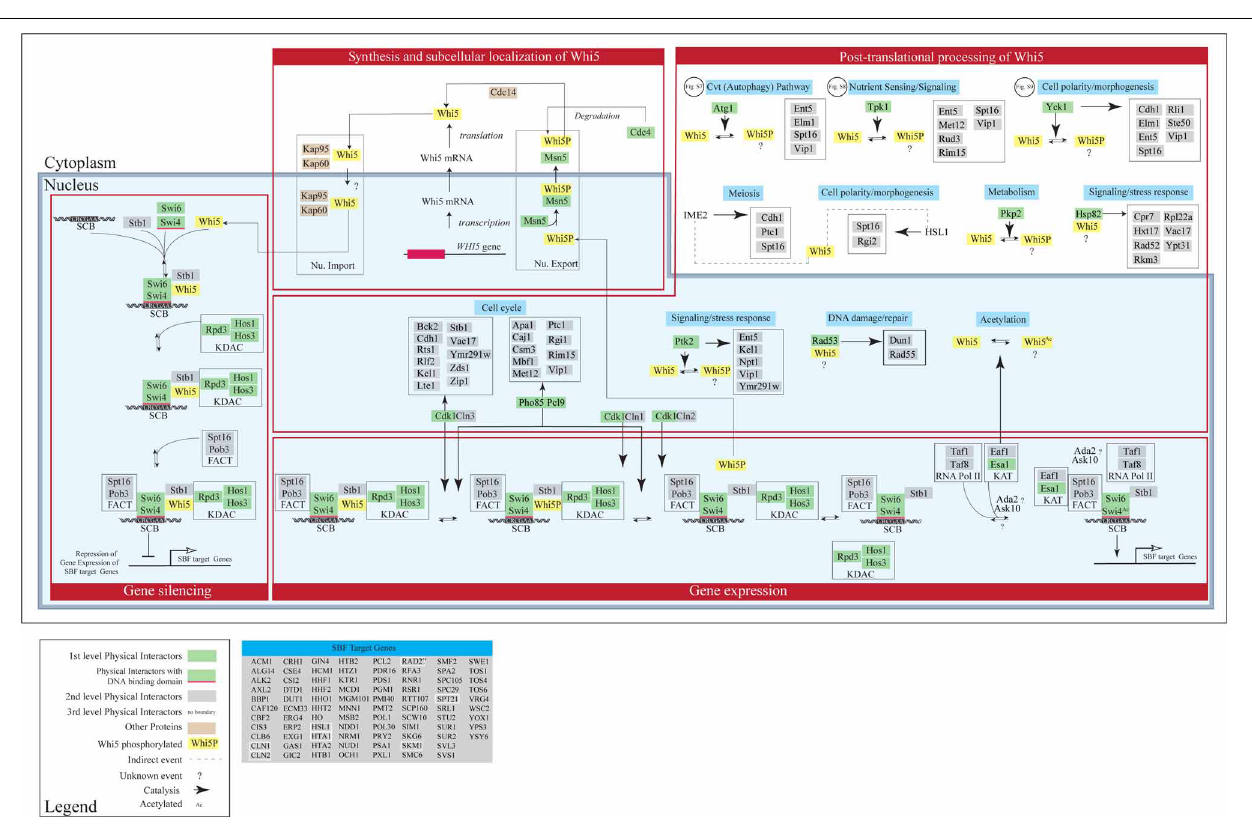
FIGURE 8 | Functional classification and GO term enrichment map of physical interactors of Rb-like proteins. (A) The functional classification of p107 (RBL1) and p130 (RBL2) interaction network was derived from database and literature search and color-coded according to function. (B) According to BioGRID database, Rb, p107, and p130 have some unique